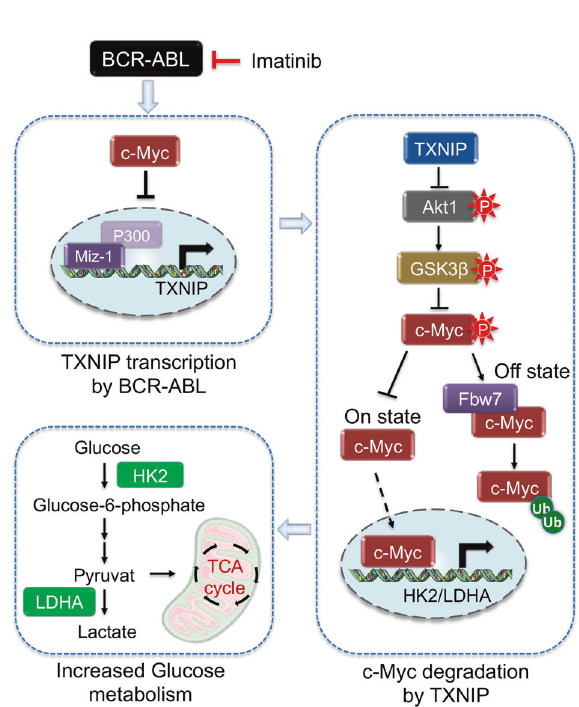
Fig. 8 Schematic drawing of the mechanism by which BCR-ABL signaling triggered glucose-dependent survival program through TXNIP suppression by regulating c-Myc/Miz1 complex. TXNIP suppresses HK2 and LDHA expressions through accelerating Fbw7- dependent c-Myc degradation by the phosphorylation of Akt/ GSK3 β